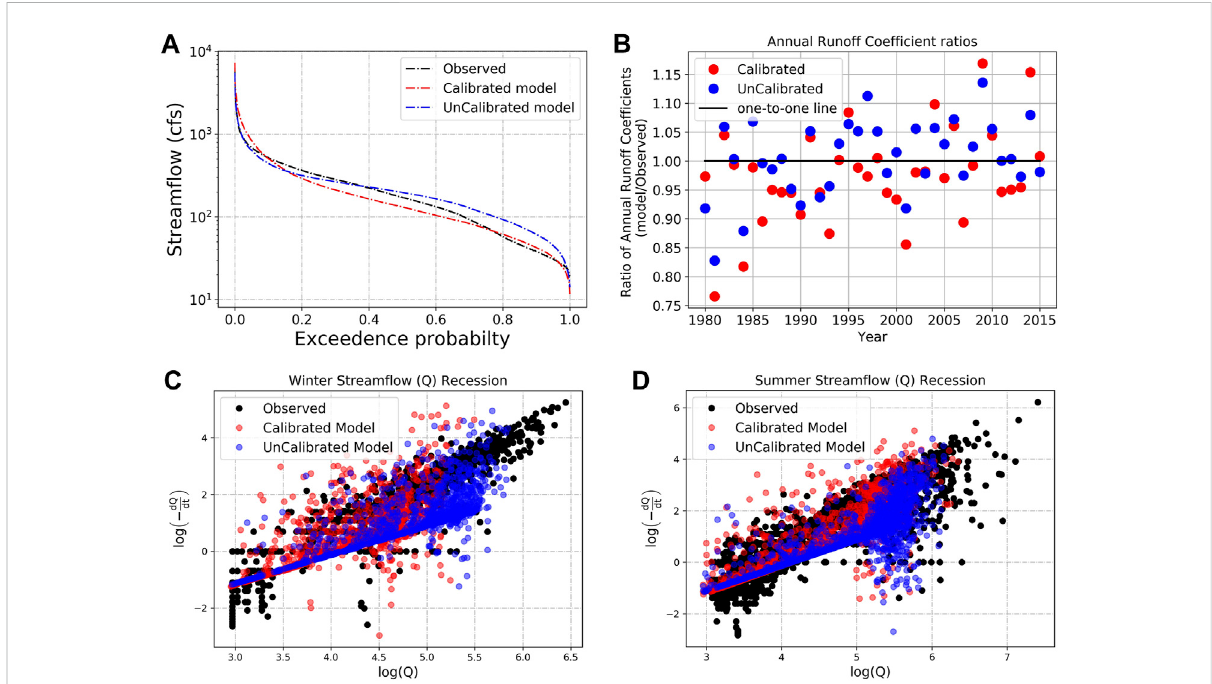
FIGURE 5 Hydrological signature-based evaluation of NHM-PRMS predictions of daily stream fl ow at Cedar River, WA over 1980 – 2016: (A) fl ow duration curve, (B) annual(i.e.,Octoberto September wateryear)runoff coef fi cient, (C) winter/cold season(months October toMarch)recessioncurvesand, (D) summer/warm season (months April to September) recession curves. The seasons and the corresponding months can be adaptively de fi ned in